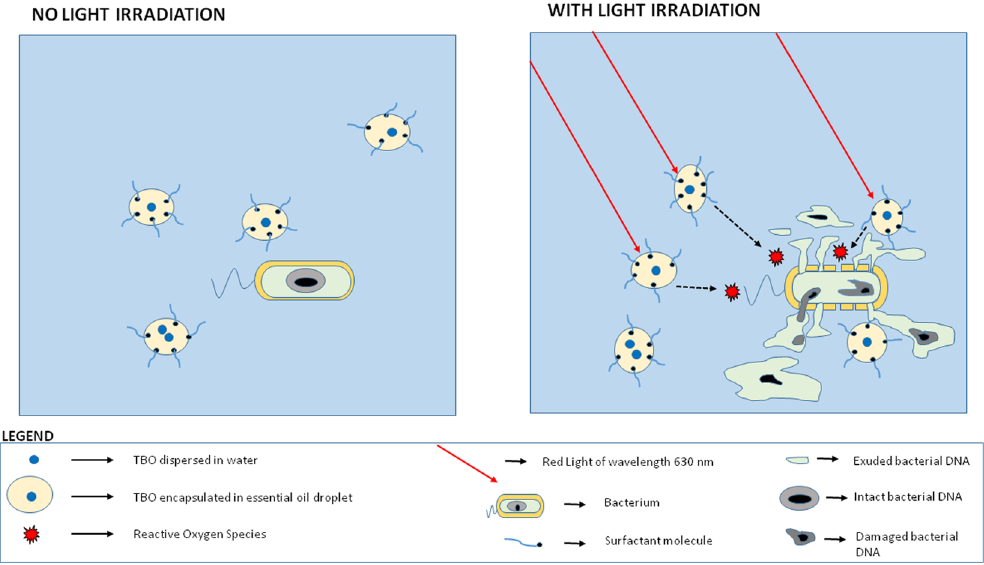
Figure 4. Schematic diagram for bacterial exudation studies after treatment with PAT. Usage of lipid nanoparticles for encapsulating TBO enhanced damage to bacterial cell and increased oxidative damage the leakage of cellular contents as compared to TBO in